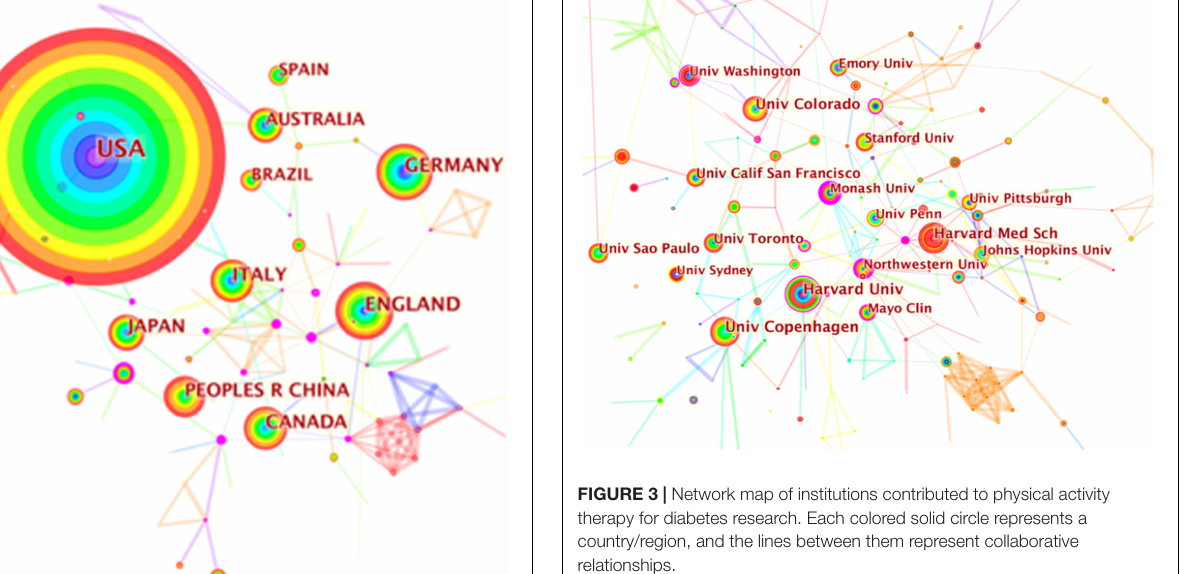
FIGURE 2 | Network map of countries contributed to physical activity therapy for diabetes research. Each colored solid circle represents a country/region, and the lines between them represent collaborative relationships.